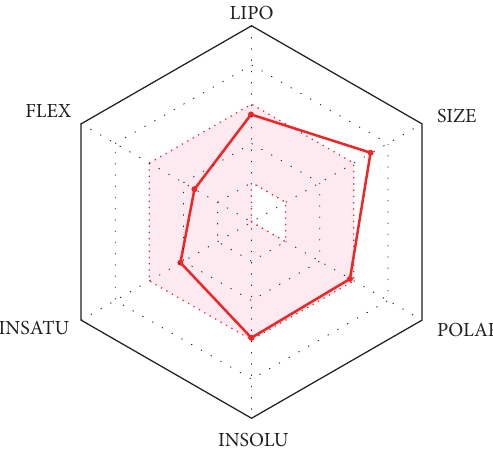
Figure 6: Bioactivity radar of the alternaramide marine cyclopentadepsipeptide.